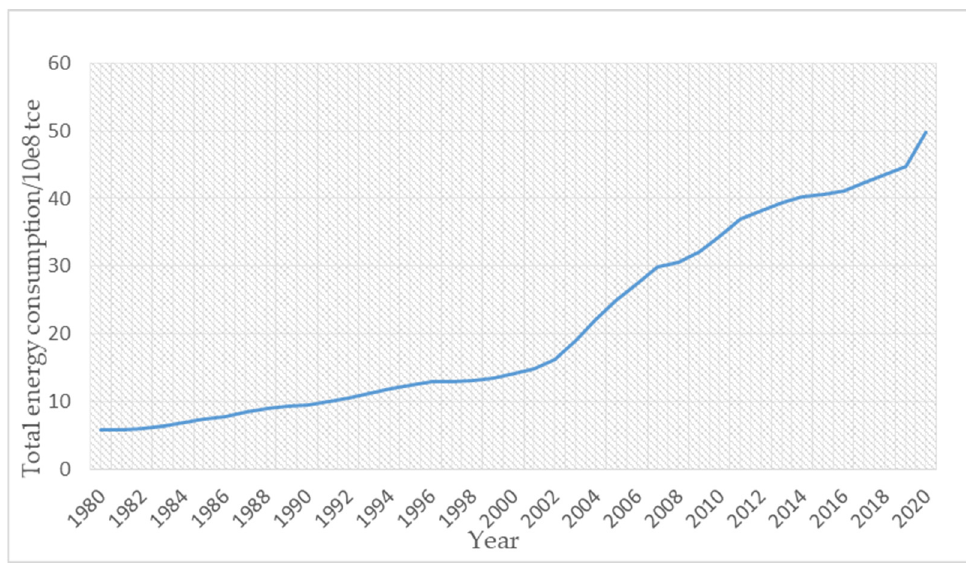
Figure 1. Trend chart of total energy consumption in China.